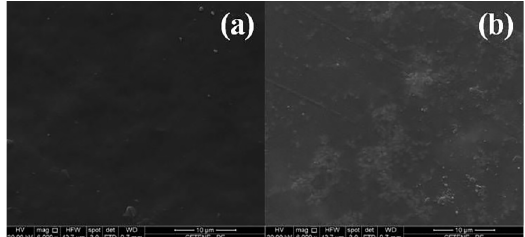
Figure 5. SEM micrographs of a) PVC film and b) PVC/ZnS film (0.7%wt).